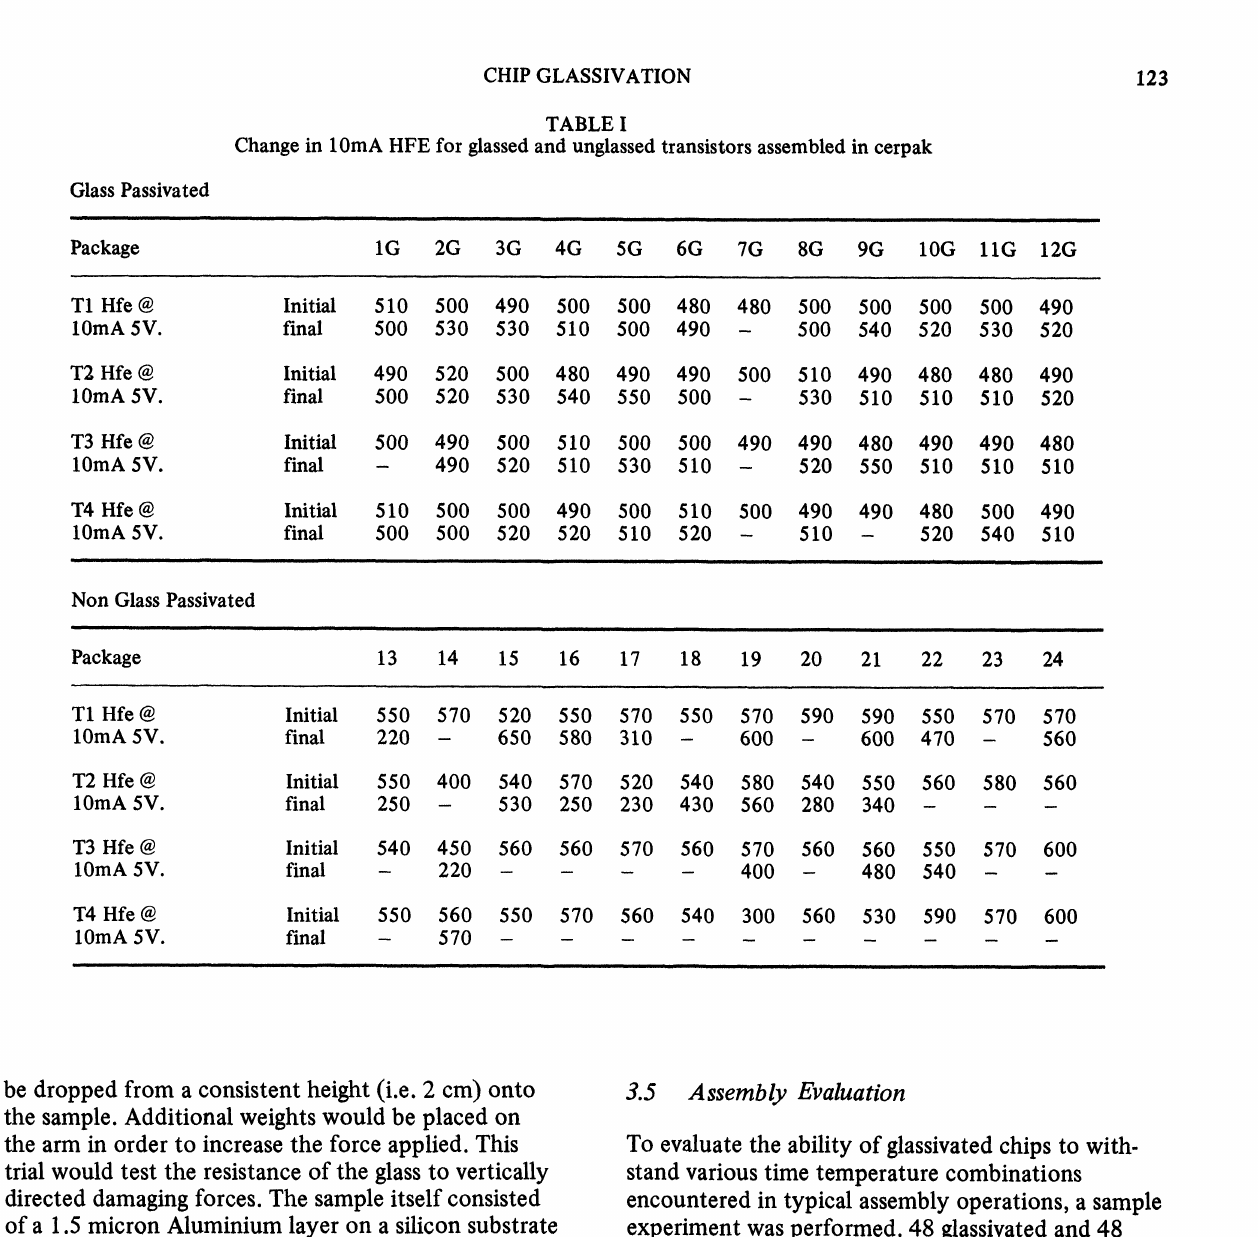
TABLE Change in 10mA HFE for glassed and unglassed transistors assembled in